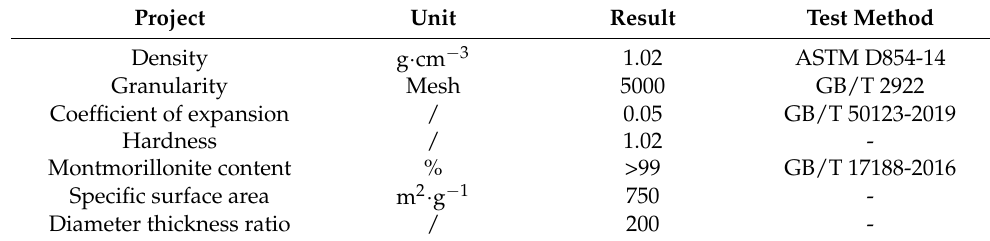
Table 4. Basic performance of